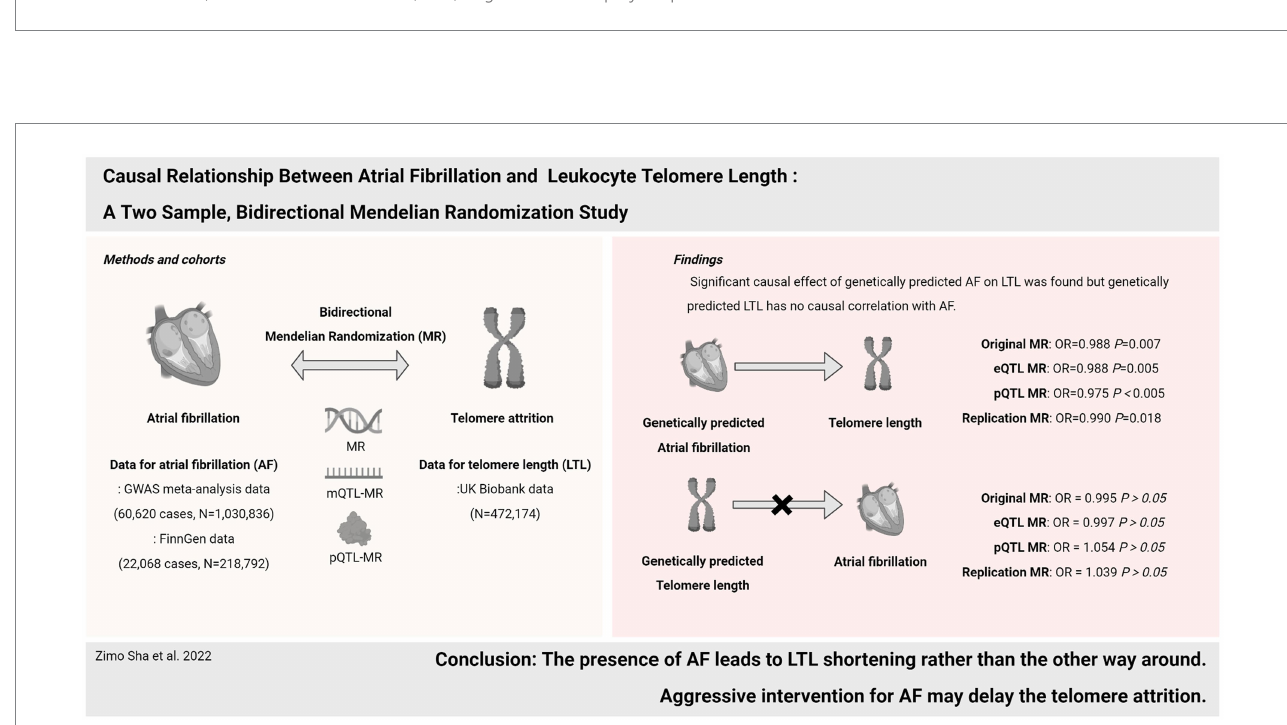
FIGURE 3 Scatter plot of SNPs associated with leucocyte telomere length and atrial fibrillation. (A) AF-LTL in MR analysis. (B) AF-LTL in eQTL-MR analysis. (C) AF-LTL in pQTL-MR analysis. (D) LTL-AF in MR analysis. (E) LTL-AF in eQTL-MR analysis. (F) LTL-AF in pQTL-MR analysis. The plot related the effect sizes of the SNP– exposure association ( x -axis, SD units) and the SNP–outcome associations [ y -axis, log (OR)] with 95% confidence intervals. The regression slopes of the lines correspond to causal estimates based on the inverse variance weighted method, MR-Egger regression, weighted median, simple mode, and weighted mode estimator. MR, Mendelian randomization; SNP, single-nucleotide polymorphism.